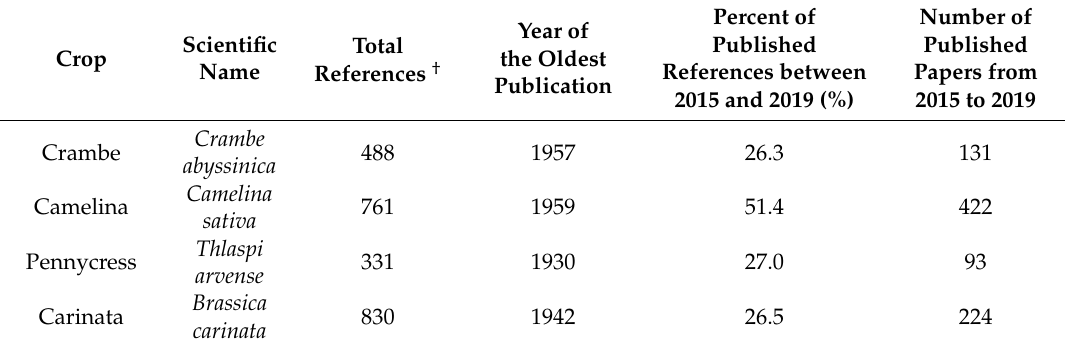
Table 3. Research publications in crambe compared with other emerging oilseed crops from the Brassicaceae